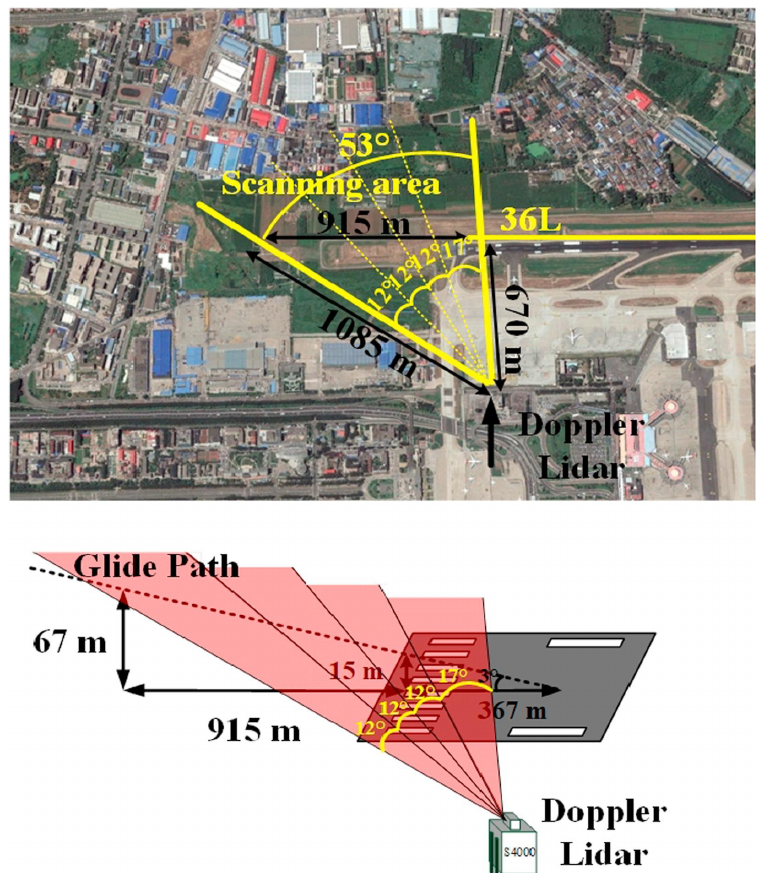
Figure 6. A step-wise scan along the glide path applied to detect wind shear during aircraft landing at the Beijing Capital International Airport [91]. The elevation angles φ are 3 ◦ , 2 ◦ , 1 ◦ and 0 ◦ in the range of azimuth angles θ = 207 ◦ –219 ◦ , 219 ◦ –231 ◦ , 231 ◦ –243 ◦ and 243 ◦ –260 ◦ ,